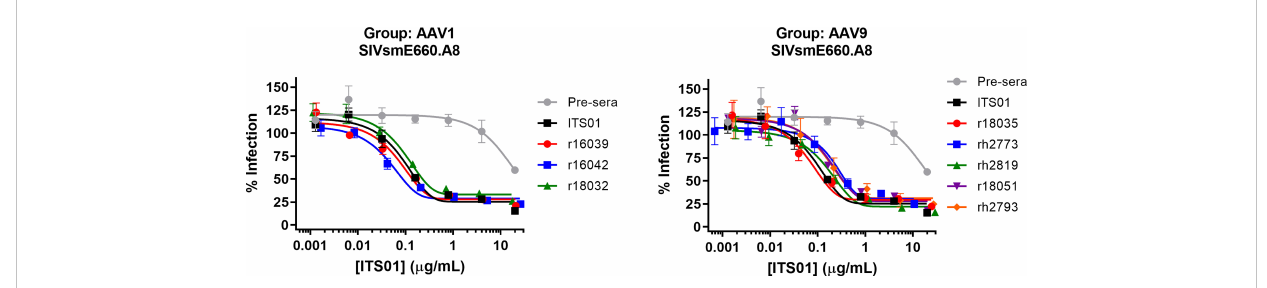
FIGURE 6 ITS01 from macaque serum retains its neutralizing activity in ex vivo neutralization assays. Neutralization activity of serum samples from 30 weeks post AAV administration for the AAV1 (left) and AAV9 (right) macaques against SIVsmE660.A8 pseudovirus was assessed by TZM-bl neutralization activity. A serum sample from before AAV vector administration was used as a negative control and the same serum sample with a known concentration of ITS01 was used as a positive control. Error bars indicate